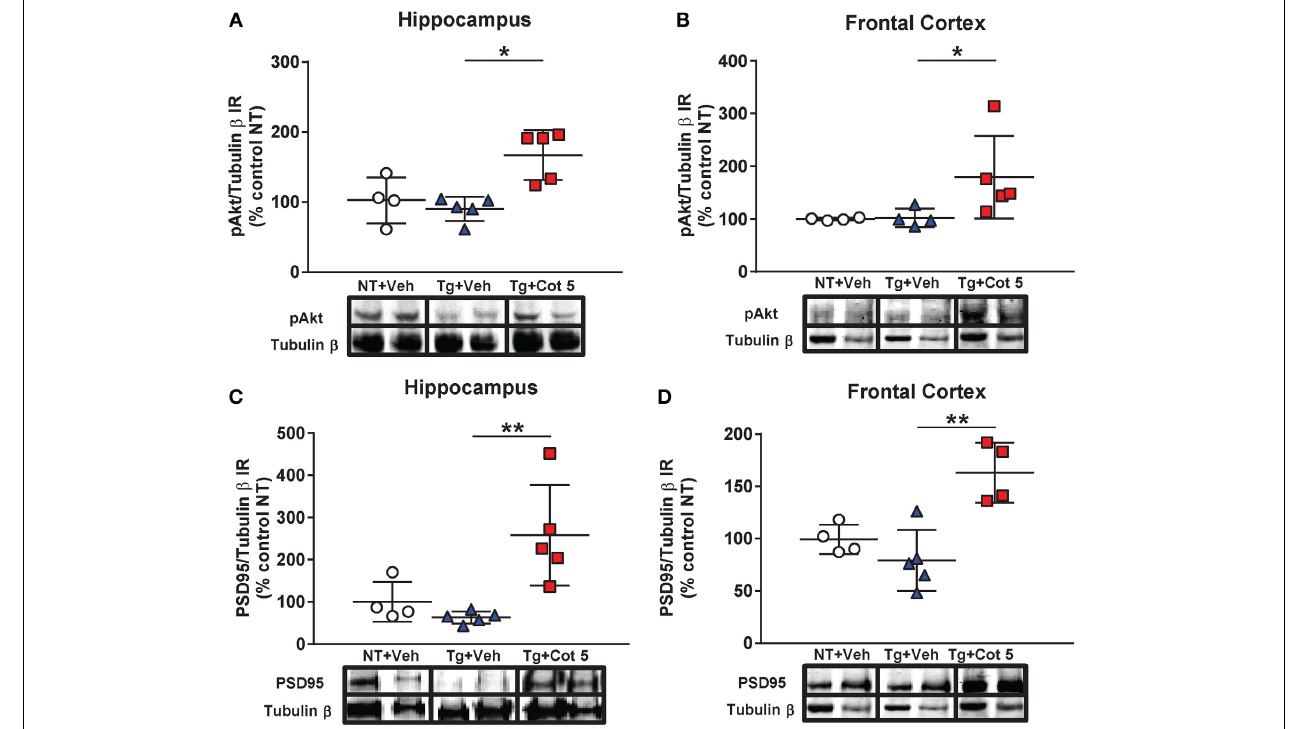
FIGURE 4 | Cotinine stimulated the Akt/PSD95 pathway in the hippocampus and frontal cortex of Tg6799 mice. Western blot analysis of the immunoreactivity (IR) for phosphorylated Akt (pAkt), PSD95 and tubulin β in the hippocampus and frontal cortex of vehicle-treated non-transgenic (NT) control mice (NT + Veh), vehicle-treated transgenic (Tg) mice (Tg + Veh), and cotinine-treated Tg mice (Tg + Cot 5). Tg + Cot 5 mice had significantly greater levels of